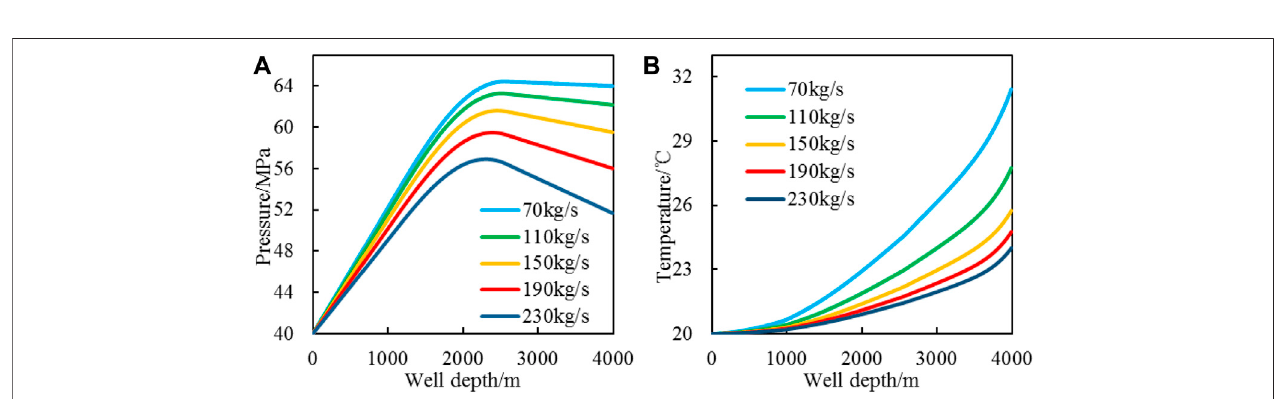
FIGURE 9 | CO 2 foam fracturing fl uid pressure and temperature change with mass fl ow rate [ (A) : pressure pro fi le; (B) : temperature pro fi le].